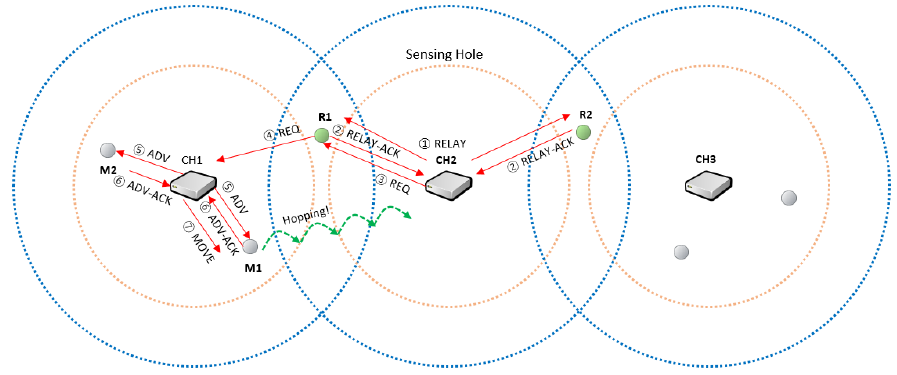
Figure 4. An example of hopping sensor relocation through the proposed protocol.